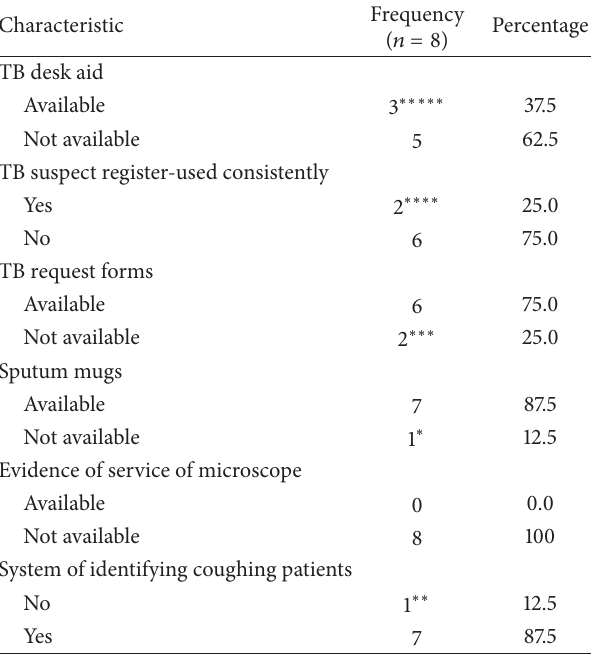
Table3:Structuralandoverallorganizationalcharacteristicsamong